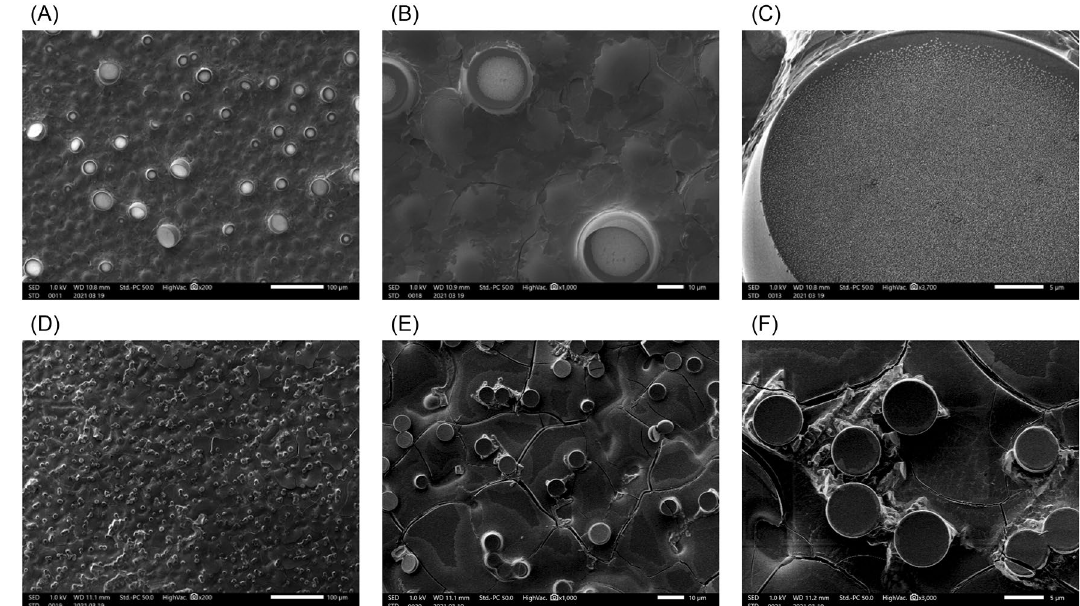
Figure 8. SEM image of self-assembled structure of AADAAC-F4 coacervated at 25 °C. ( A – C ) SEM images of the coacervate of AADAAC-F4 in the absence of Cd 2+ . The magnifications for the images are 200 × for ( A ), 1000 × for ( B ), and 3700 × for ( C ). ( D – F ) SEM images of the coacervate of AADAAC-F4 in the presence of Cd 2+ . The magnifications for the images are 200 × for ( D ), 1000 × for ( E ), and 3000 × for ( F ).